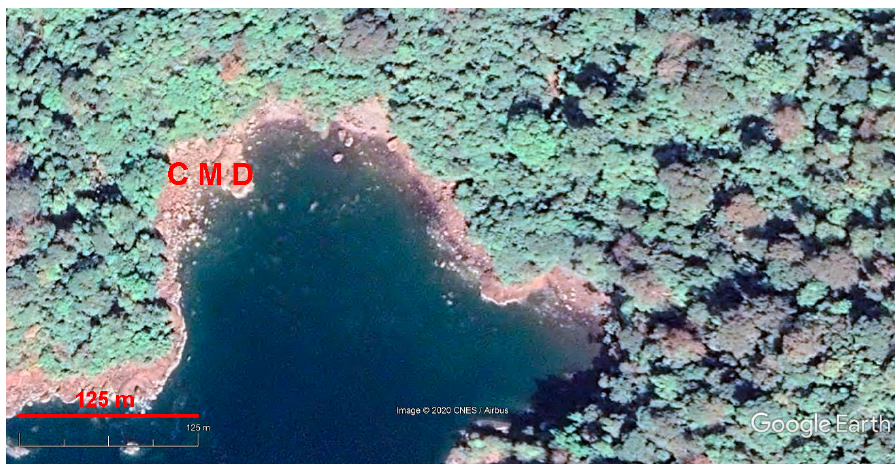
Figure 8. The southern plot of the Humboldt o Coredo Bay locality (the view provided by the Google Earth Engine). J. Mar. Sci. Eng. 2020 , 8 , x FOR PEER REVIEW